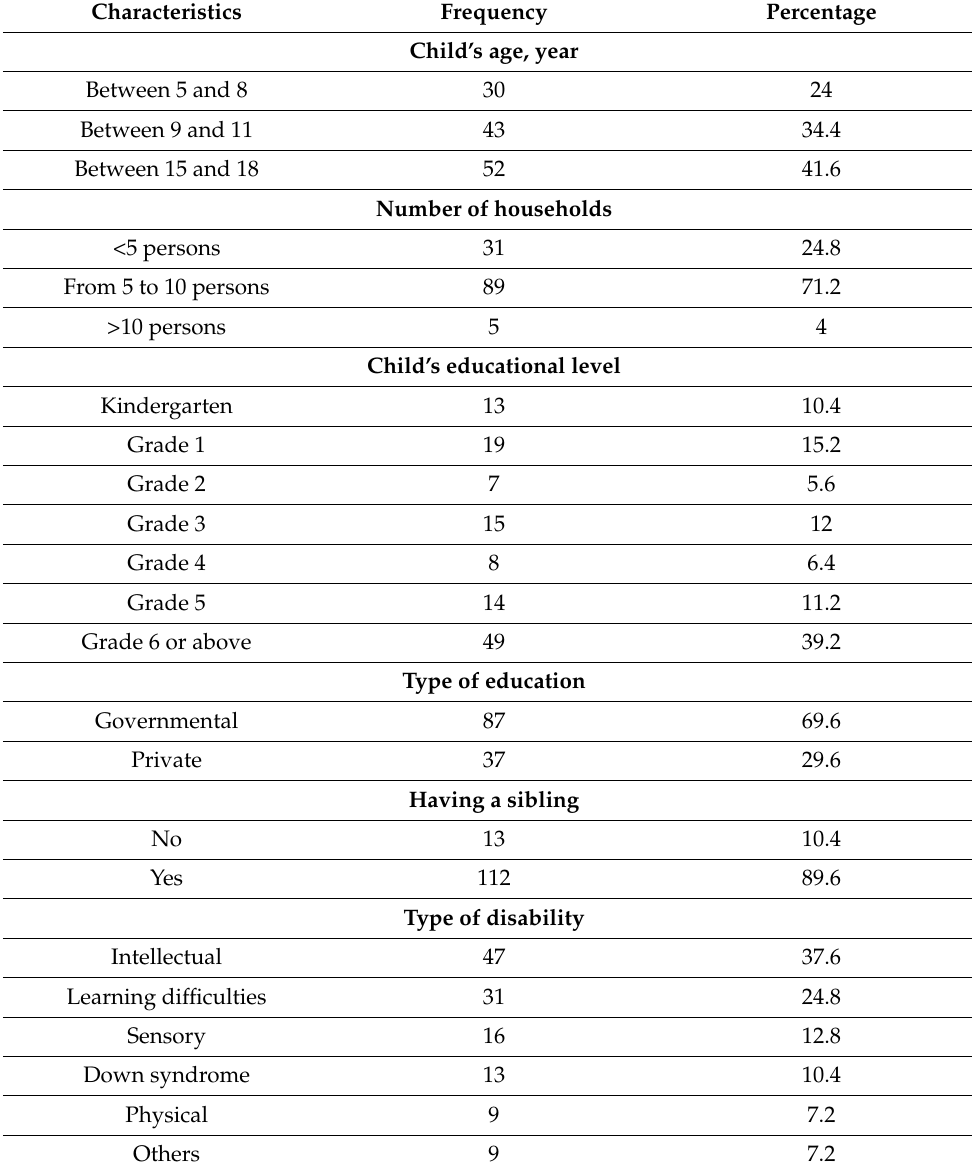
Table 1. Personal characteristics of the